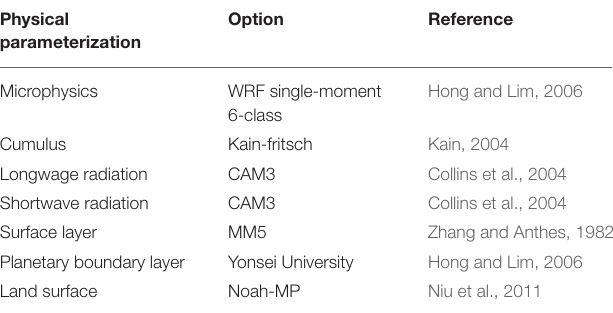
TABLE 1 | Physical parameterization options used in all experiments and their main